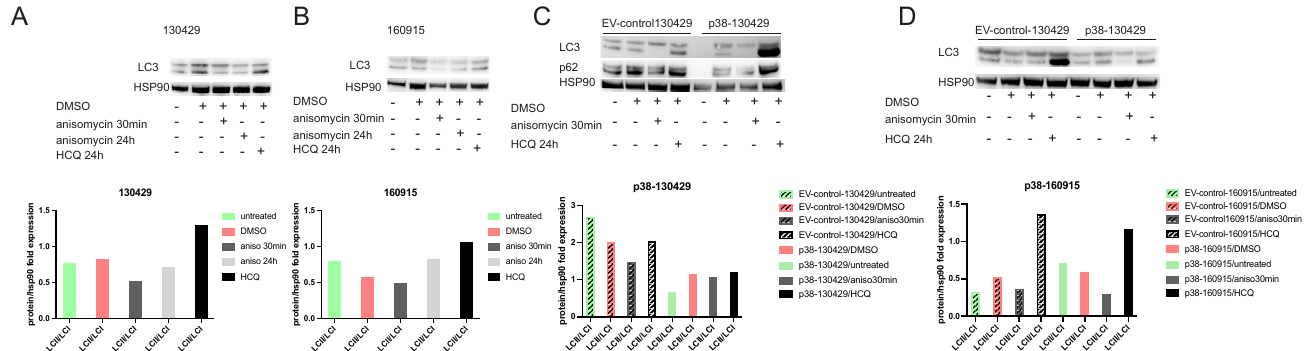
Figure 7. Transient suppression of autophagy by reduced conversion of LC3 with p38 activation. ( A ): Protein expression of LC3 with HSP90 as the loading control under untreated, DMSO, 0.1 µ M anisomycin treatment for 30 min or 24 h, and 10 µ M HCQ treatment for 24 h in cell line 130429. Densitometry plot represents the expression of proteins as the fold change in relation to HSP90 expression. ( B ): Protein expression of LC3 with HSP90 as the loading control under untreated, DMSO, 0.1 µ M anisomycin treatment for 30 min or 24 h, and 10 µ M HCQ treatment for 24 h in cell line 160915. Densitometry plot represents the expression of proteins as the fold change in relation to HSP90 expression. ( C ): Protein expression of p62 and LC3 with HSP90 as the loading control under untreated, DMSO, 0.1 µ M anisomycin treatment or 24 h, and 10 µ M HCQ treatment for 24 h in EV control–130429 and p38–130429 cell lines. Densitometry plot represents the expression of proteins as the fold change in relation to HSP90 expression. ( D ): Protein expression of LC3 with HSP90 as the loading control under untreated, DMSO, 0.1 µ M anisomycin treatment for 30 min or 24 h, and 10 µ M HCQ treatment for 24 h in EV control–160915 and p38–160915 cell lines. Densitometry plot represents the expression of proteins as the fold change in relation to HSP90